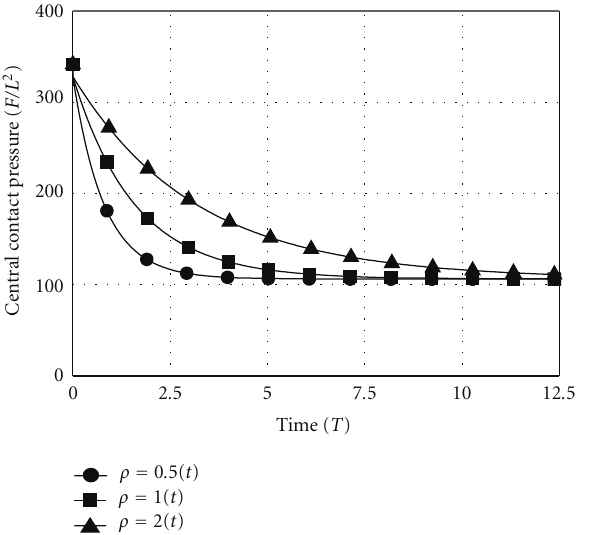
Figure 17: E ff ect of ρ on relaxation of the central contact pressure.